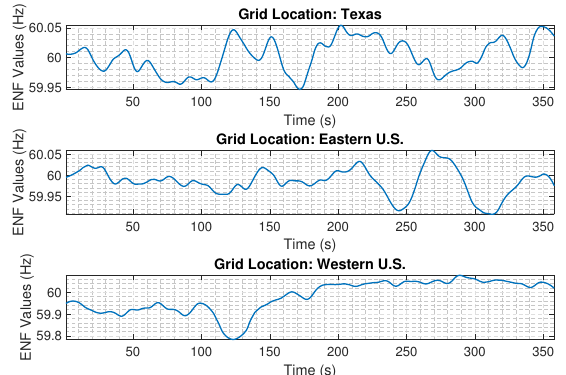
Figure 2. Sample ENF sequences extracted from audio recordings from different 60 Hz grid locations.